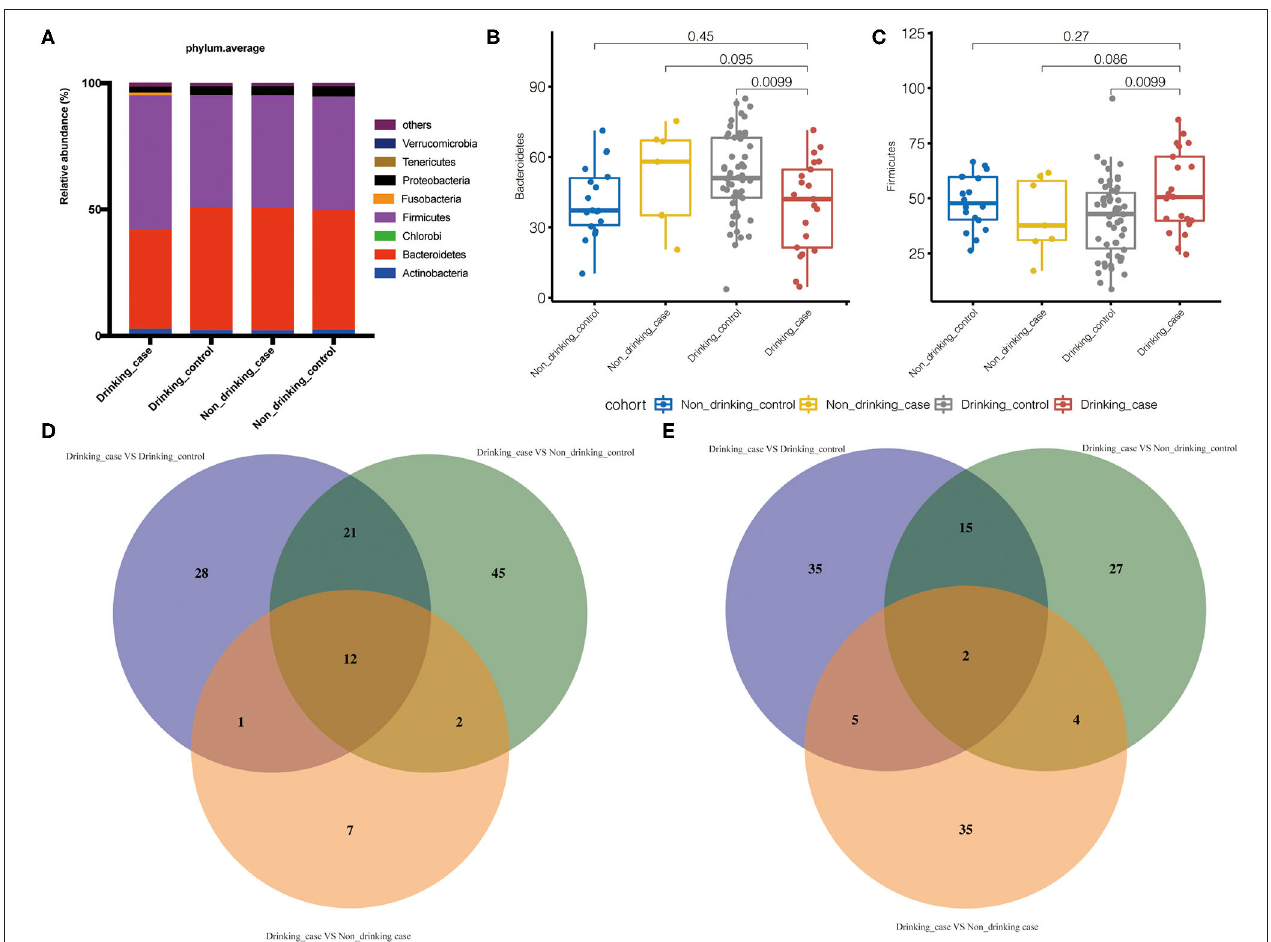
FIGURE 4 | Differential gut microbiota in the drinking case group. (A) The average compositions and relative abundance at phylum level of the four groups; (B,C) the abundance of phyla Bacteroidetes and Firmicutes in the four groups; and (D,E) the statistically differential overlaps in the distribution of gut microbiome metabolic pathways and